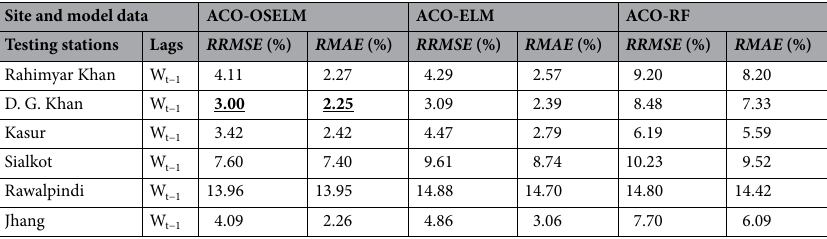
Table 8. It demonstrated that D. G. Khan is the station where the ACO-OSELM wheat yield predicting model performed the best with RRMSE ≈ 3.00 and RMAE ≈ 2.25% . The ACO-OSELM model was found to generate the least relative percentage error values (i.e., RRMSE, RMAE ) at all tested stations except for the Rawalpindi station. However, the predicted errors generated by the proposed two-phase hybrid ACO-OSELM model were low in terms of their relative error values, and more importantly, the error values were within the recommended range of 10% threshold for an excellent model classification, except for Rawalpindi station 97 . Figure 11 presents the absolute prediction error |PE| in each year from 1981–2013 of the proposed two-phase hybrid ACO-OSELM versus ACO-ELM and ACO-RF models at the testing stations in the form of polar plots. For all stations, the prediction errors generated by the proposed two-phase hybrid ACO-OSELM were very low compared to the ACO-ELM and ACO-RF models. This was justified by the minimum values of relative predic- tion errors. The |PE| errors were significantly smaller in each year for the proposed two-phase hybrid ACO- OSELM model as compared to ACO-ELM and ACO-RF models in Rahimyar Khan, D. G. Khan, Kasur, Sialkot, Rawalpindi and Jhang stations. Overall, the proposed two-phase hybrid ACO-OSELM model generated better significant accuracy with smaller error statistics and higher WI .